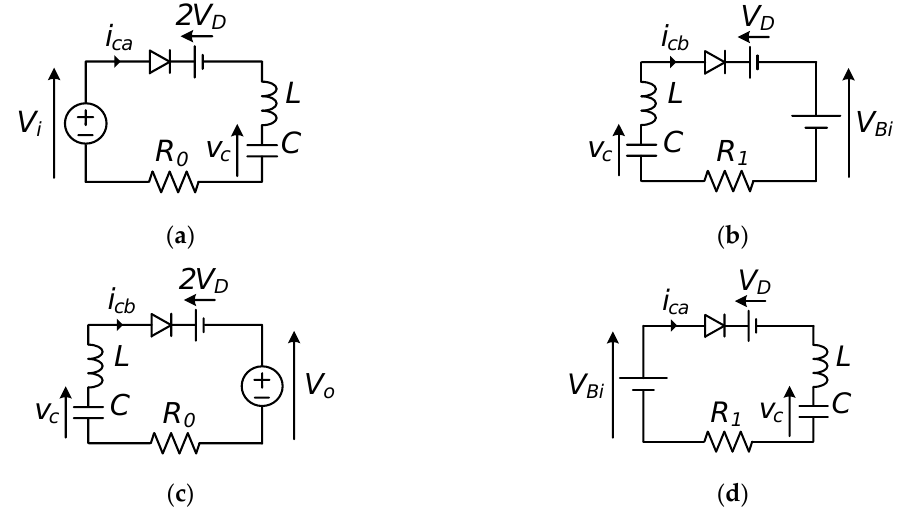
Figure 3. Equivalent circuits of the charging/discharging paths of the switched-capacitor; ( a ) conduction stage of T 0 in the SIMO configuration; ( b ) conduction stage of T 1 in the SIMO configuration; ( c ) conduction stage of T 0 in the MISO configuration; and ( d ) conduction stage of T 1 in the MISO configuration.